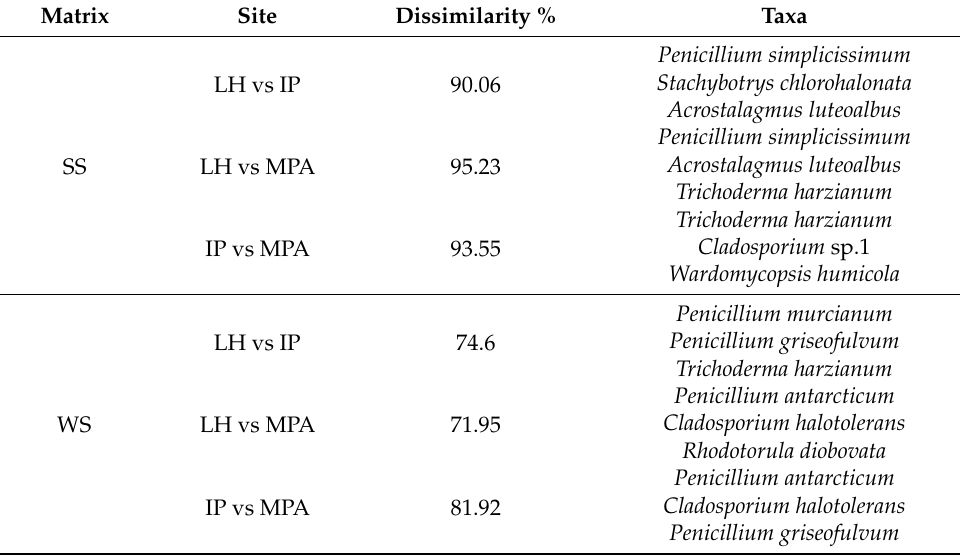
Table 3. Dissimilarity of mycobiota among the three sites in different matrices. For each couple, the three taxa that mainly contributed to the dissimilarity are reported.